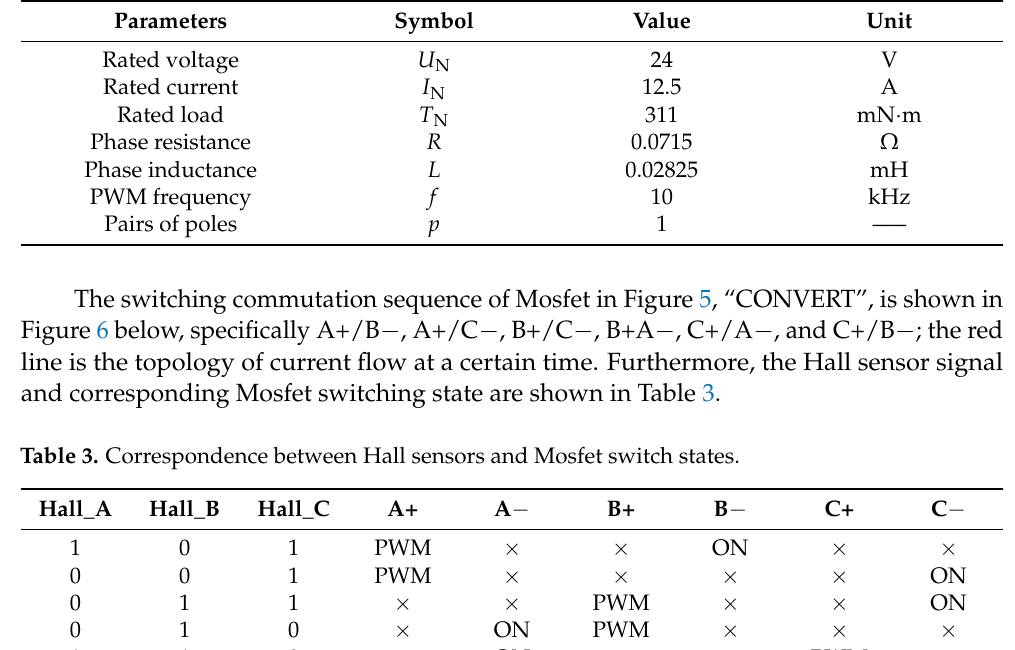
Figure 6. Logical commutation sequence of Mosfet.